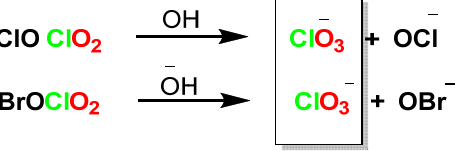
Figure 16. Formation of XOClO 2 .